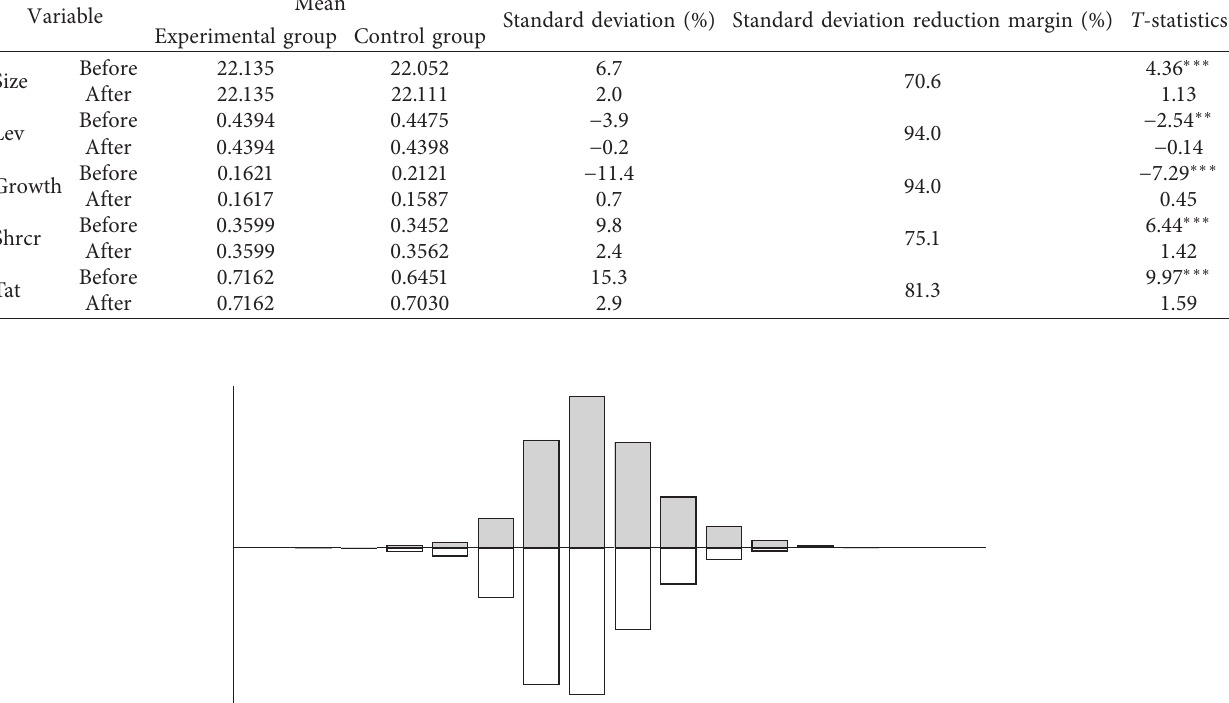
Table 6: Test of the equilibrium property of matching